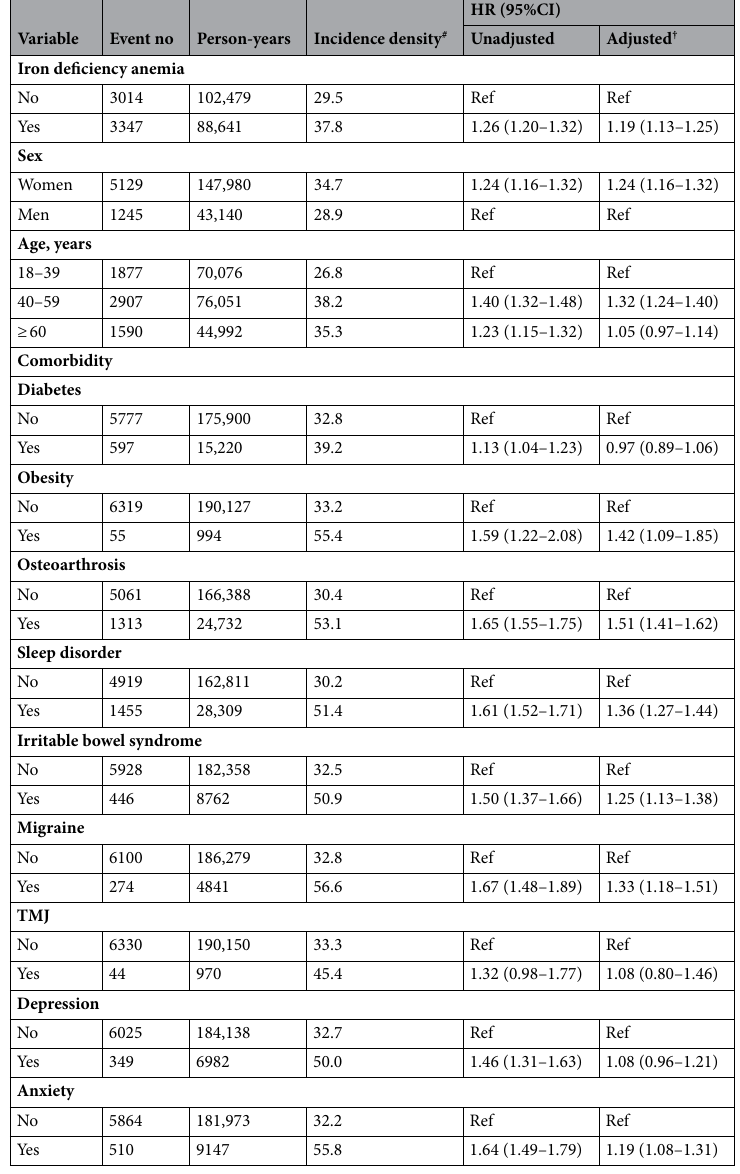
Table 2. Cox model measured hazard ratios and 95% confidence interval of fibromyalgia associated with iron deficiency anemia and covariates. HR hazard ratio, CI confidence interval. # Per 1000 person-years. † Multivariate Cox proportional hazards regression model including iron deficiency anemia sex, age, diabetes, obesity, osteoarthrosis, sleep disorder, irritable bowel syndrome, migraine, TMJ, depression, and